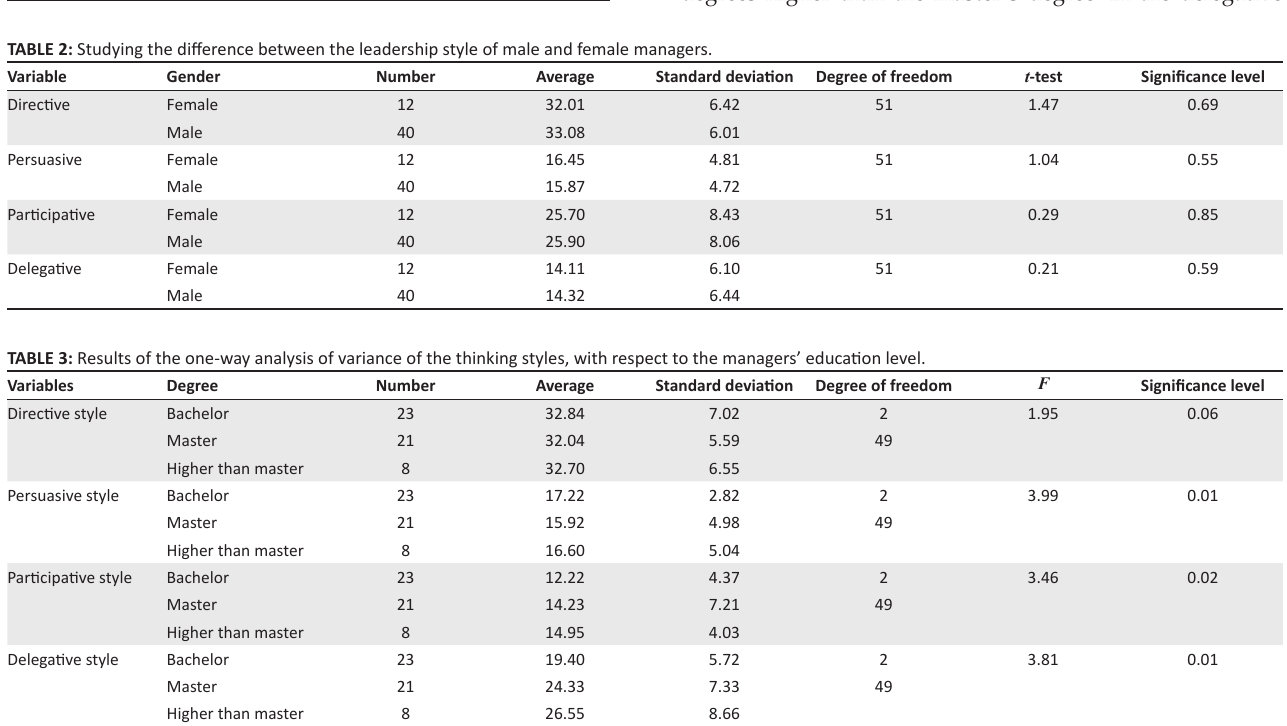
TABLE 1: The questionnaire items and reliability coefficients. Styles